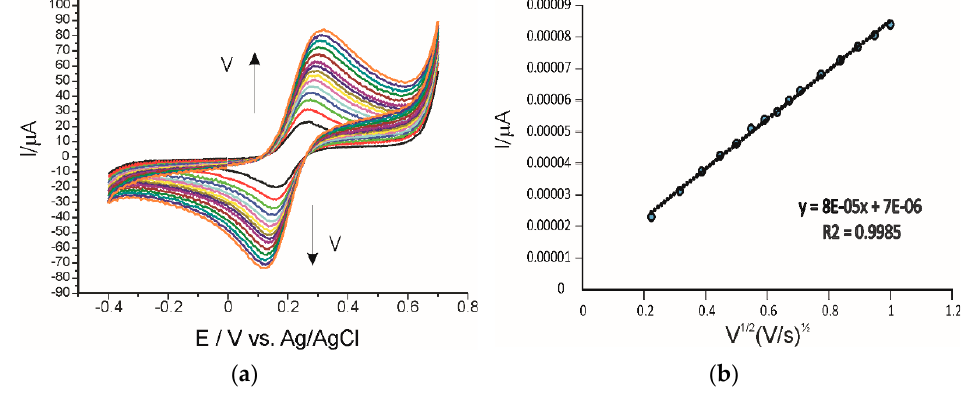
Figure 2. ( a ) Cyclic voltammograms of the AuNP-CNT/SPCE electrode in solution 10 − 3 M K 4 [Fe(CN) 6 ] − 10 − 1 M KCl at various scan rates (0.05–1.0 V/s) ( b ) Dependence I pa vs. square root of the scan rate.